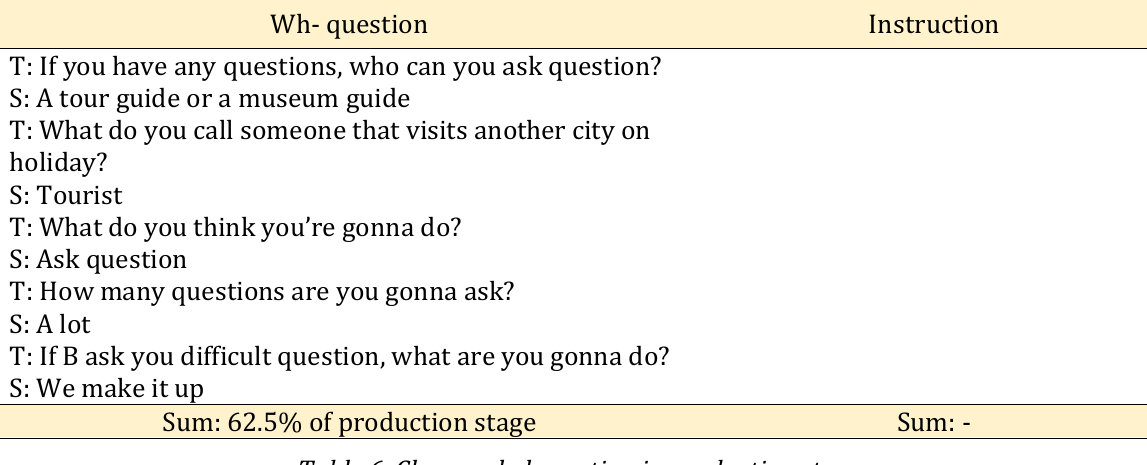
Table 6. Close-ended question in production stage Yes/no question Giving